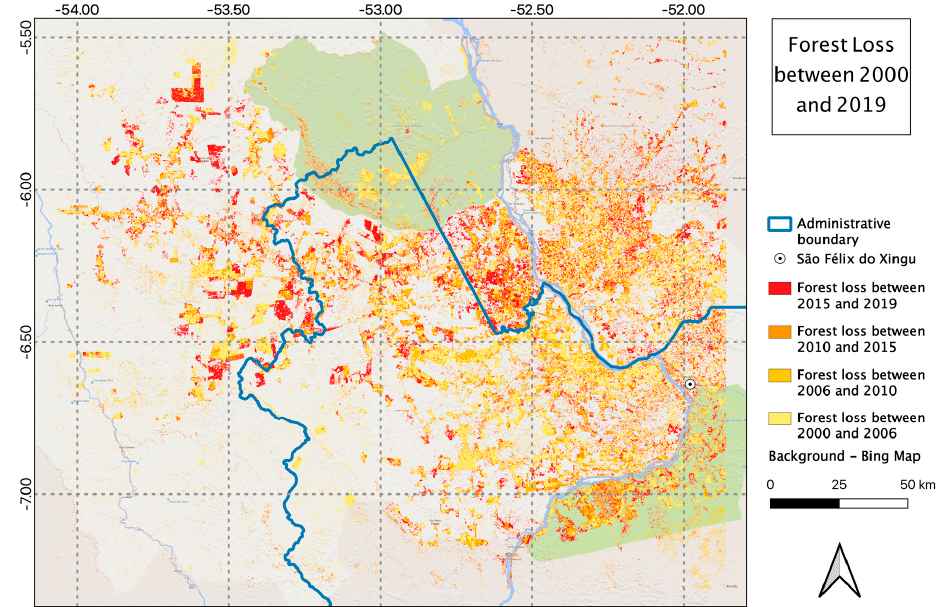
Figure 6. Cumulative forest Loss from 2000 to